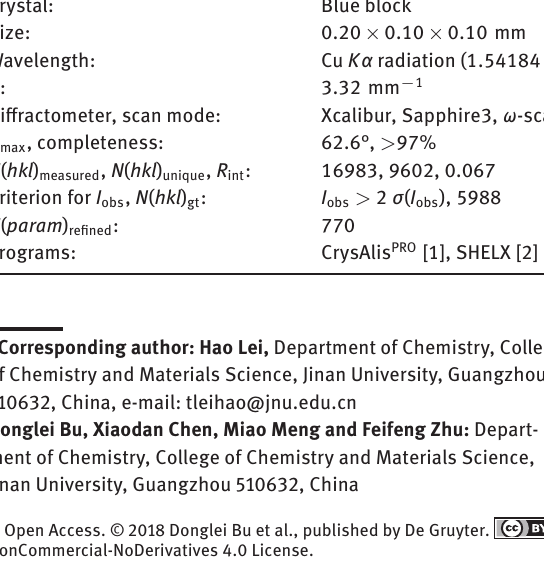
The title crystal structure is shown in the figure. Hydrogen atoms are omitted for clarity. Tables 1 and 2 contain details